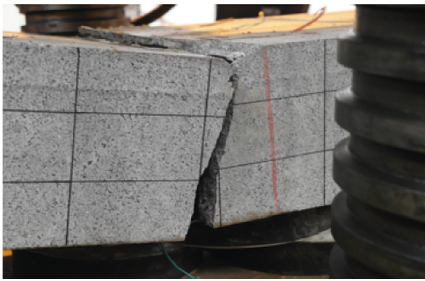
Figure 14: Failure mode of